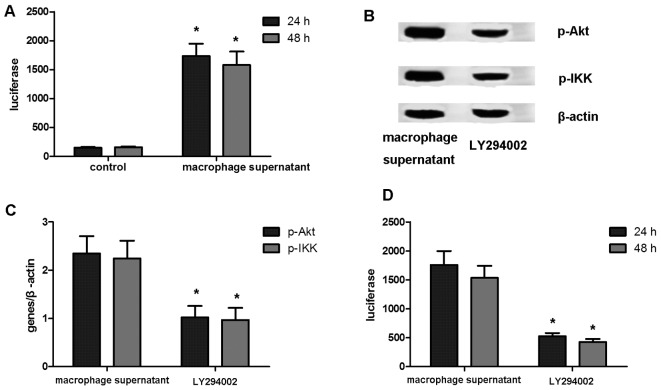
The phosphatidylinositol-3-kinase (PI3K)/protein kinase B (Akt)/inhibitory κB kinase(IKK) signaling pathway is involved in nuclear factor (NF)-κB activation induced by macrophage supernatant. (A) NF-κB activity was augmented by macrophage supernatant, *P<0.05 vs. control. (B) p-Akt and p-IKK were reduced by LY294002 (PI3K inhibitor). (C) Protein expression was analyzed using BandScan 5.0 software and normalized to β-actin; *P<0.05 vs. macrophage supernatant group. (D) NF-κB activity was reduced by LY294002; *P<0.05 vs. macrophage supernatant group.